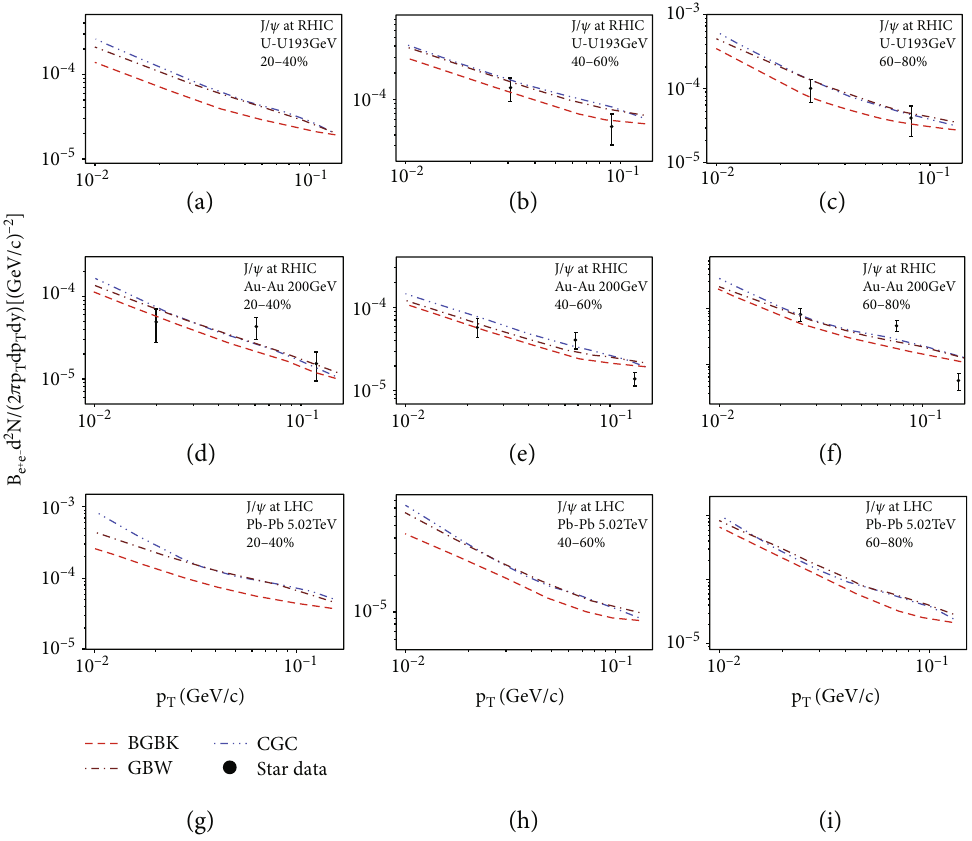
Figure 1: The very low- p J / ψ yield in relativistic heavy ion collisions. The dash line (red) is for the GBW model, the dash-dot line (wine) is T for the BGBK model, and the dash-dot-dot line (blue) is for the CGC model. The data points are from the STAR Collaboration